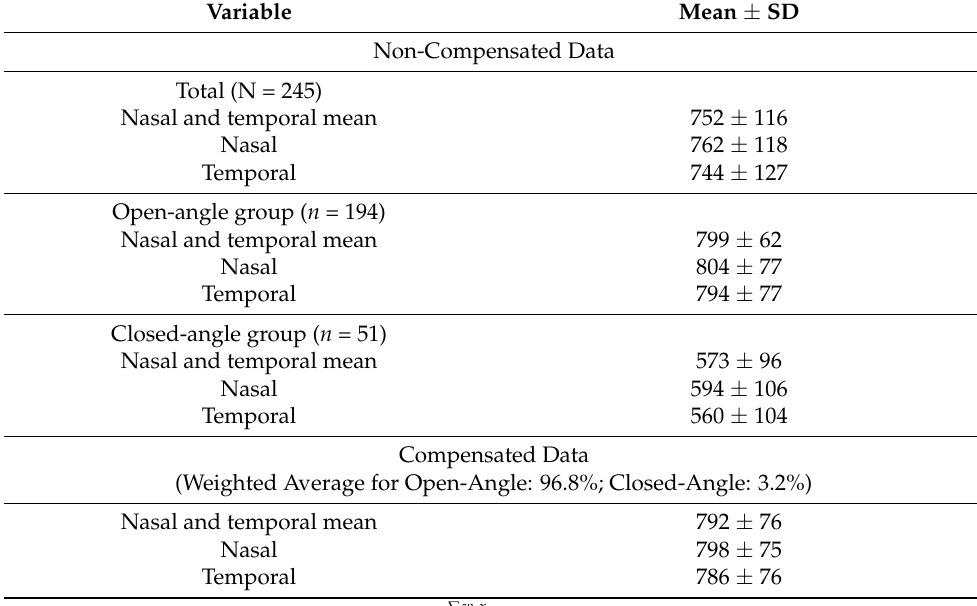
Table 2. Mean trabecular meshwork height in South